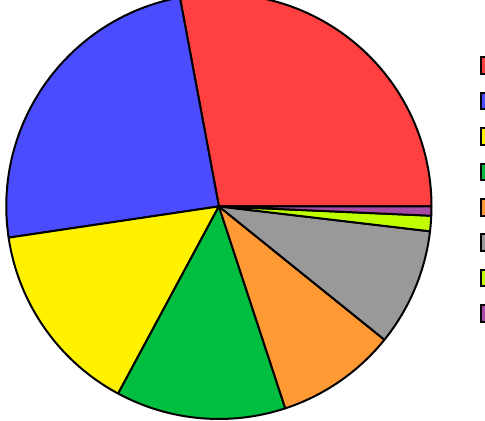
Figure 7. Relative frequency of techniques